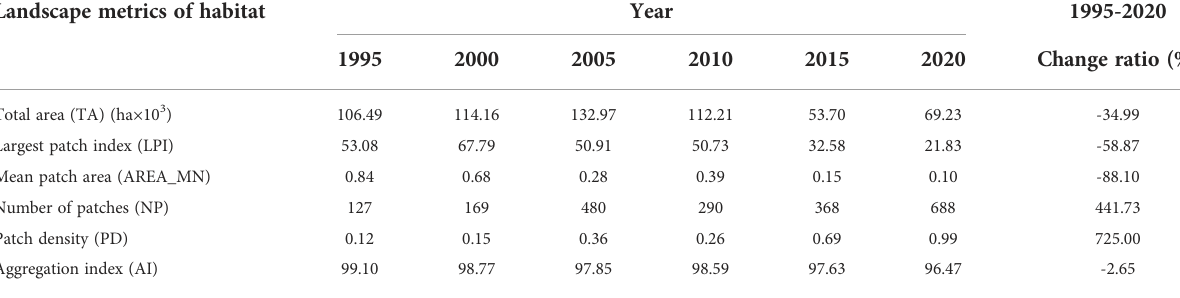
TABLE 1 Variation in the landscape metrics of shorebird habitat in the Yellow River Delta between 1995 and 2020. Landscape metrics of